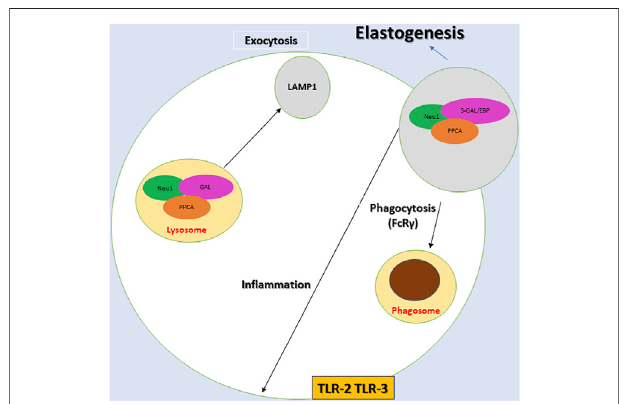
FIGURE 1 | Diagram depicting the components of the multienzyme lysosomal complex, neuraminidase 1 (NEU1), protective protein/cathepsin A (PPCA) and β -galactosidase (Gal), and the associated proposed cellular mechanisms. NEU1 activation depends on PPCA within the NEU1- PPCA-Gal and NEU1-PPCA- S-Gal/EBP complex. The process of desialylation activates the receptors for phagocytosis (FcR γ ), in fl ammation (TLR-2 and TLR3). NEU1 is also crucial for lysosomal exocytosis and elastogenesis.Itshouldbenotedthatavariant of β -galactosidaseS-Gal/EBP, NEU1, and CathA constitutes the elastin receptor that is targeted to the plasma membrane and is crucial in extracellular assembly of elastic fi bers.